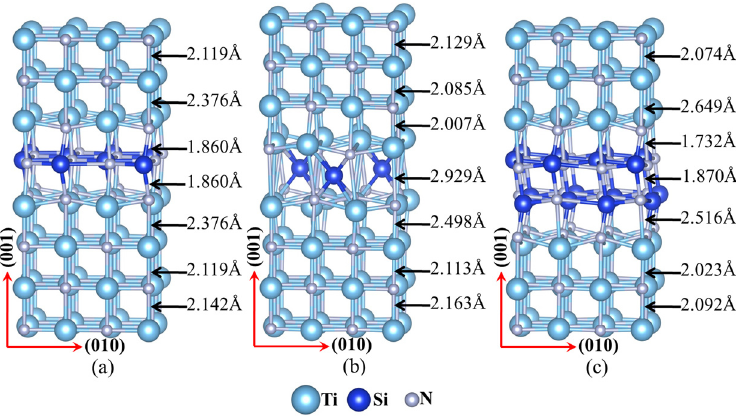
Figure 1. The atomic structures and the variations in bond lengths of the modelled interfaces in nanocomposite structural Ti–Si–N films: ( a ) substitution interface (1Si–6N); ( b ) interstitial interface (1Si–4Ti4N); and ( c ) double ‐ substitution interface.